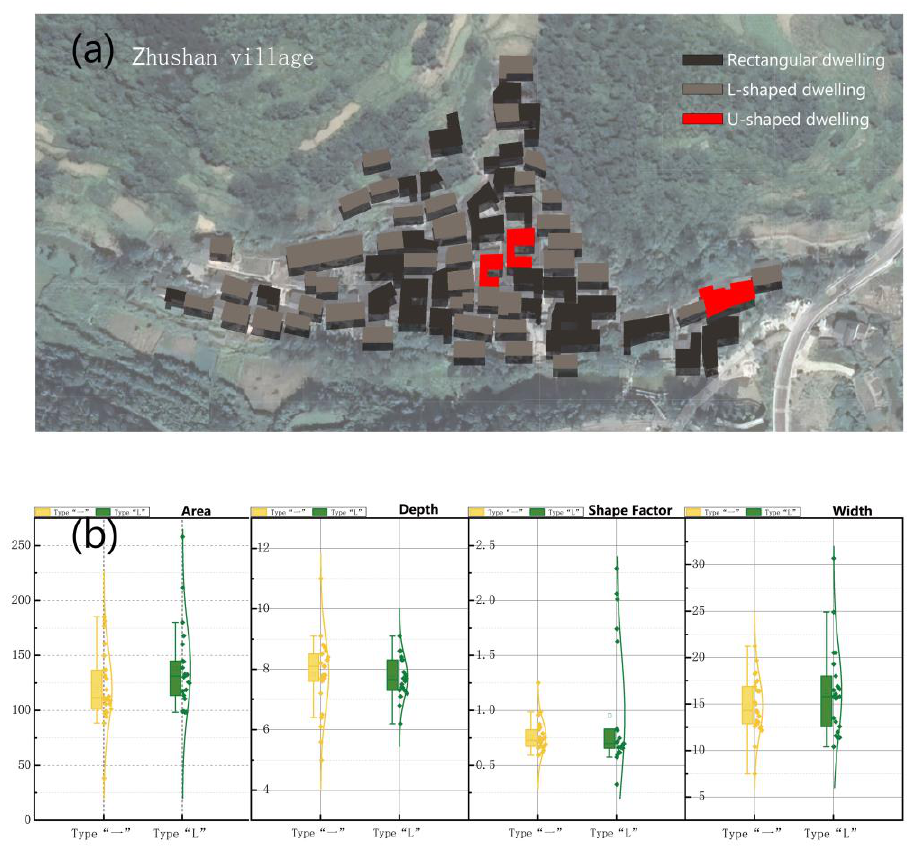
Figure 3. Analysis of Zhushan village residential forms. ( a ) Master plan of Zhushan village; ( b ) The date of residential.